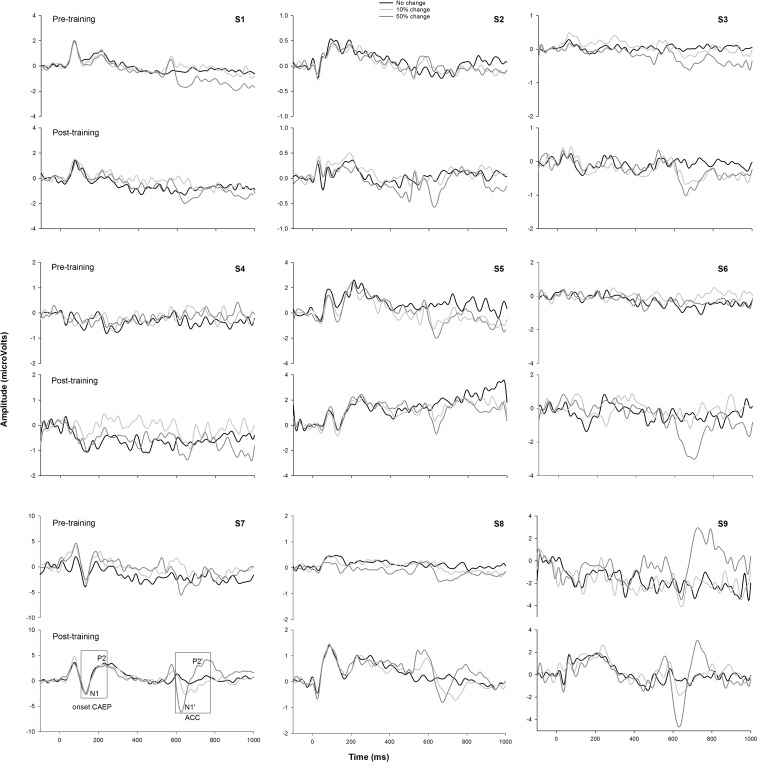
The pre- and post-training EEG data from the nine participants. Each trace represents the mean data from six electrodes (F3, Fz, F4, C3, Cz, and C4). The responses to the tones containing a 0% frequency change (black), 10% change (light gray), and 50% change (dark gray) are plotted. The onset CAEP peaks (N1 and P2) and ACC peaks (N1′ and P2′) are labeled in one subplot. Note that all participants finished a 8-week training except two participants (S2 and S9) who finished a 4-week training.